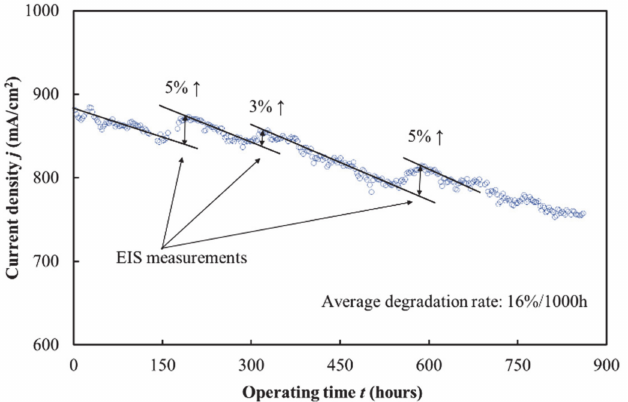
Figure 5. Dependence of current density on operating time of the Ni-YSZ|YSZ|GDC|PSC SOEC short stack measured at T = 800 ◦ C and at E = 1.5 V. A regeneration phenomenon can be seen after electrochemical impedance spectroscopy measurements.